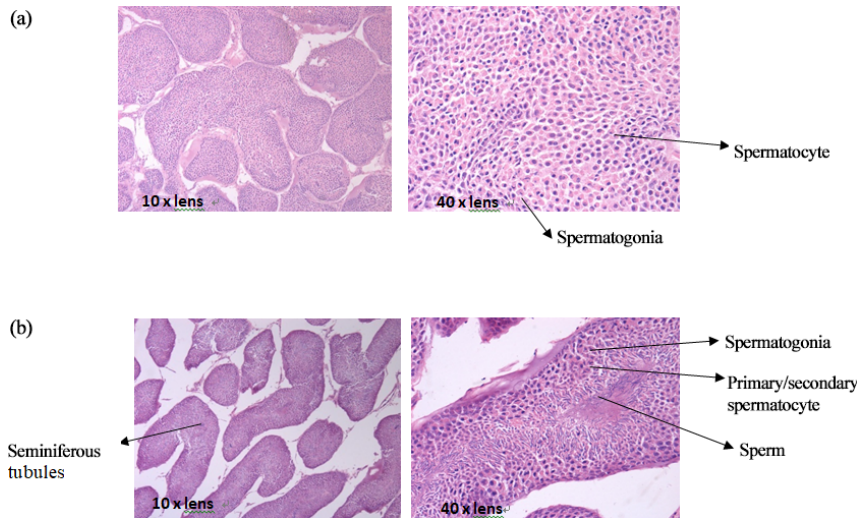
Figure 1. The paraffin slices of testis tissues from the mulard duck (a) and Pekin duck (b) .